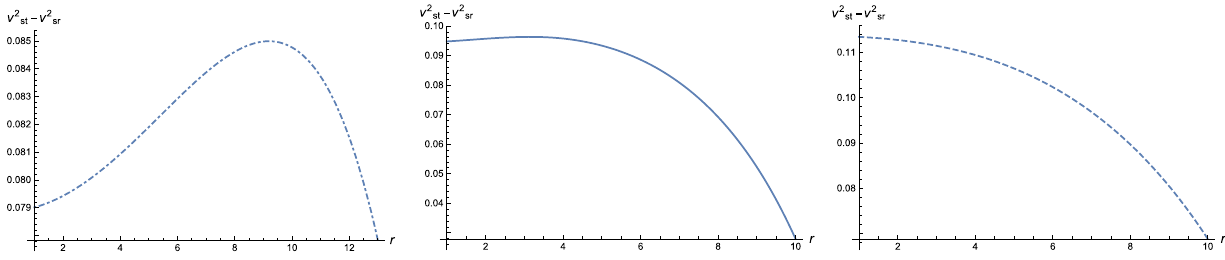
− v 2 Fig. 10 Variations of v 2 sr with respect to radius r (km) of the strange star candidate Her X-1, SAX J 1808.4-3658, and 4U 1820-30; represented st by (left to right) the first, second, and third graphs,